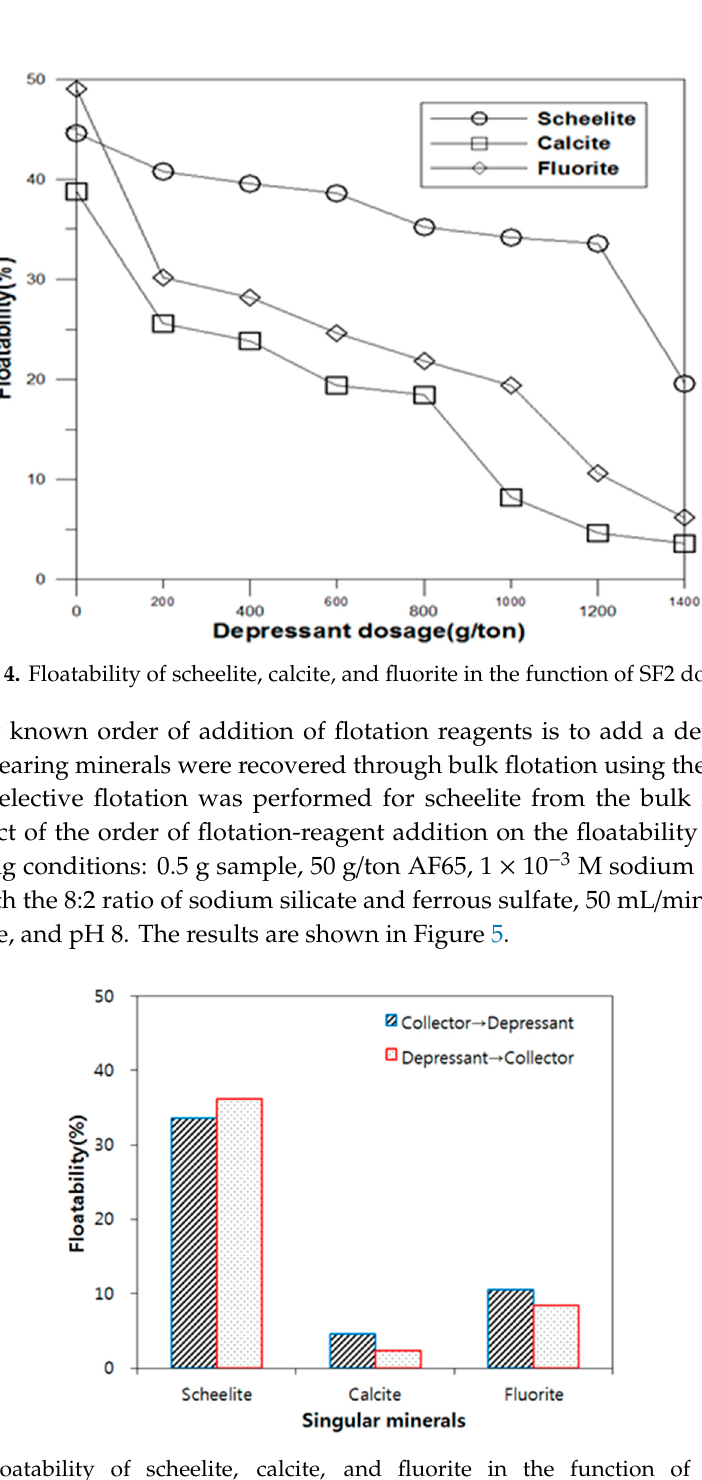
Figure 5. Floatability of scheelite, calcite, and fluorite in the function of the order of flotation-reagent